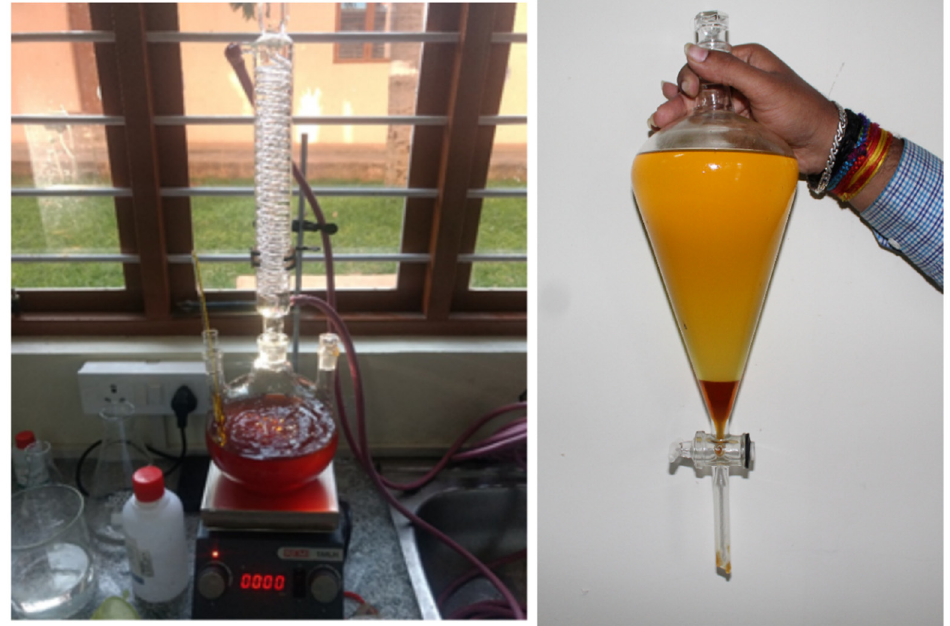
Figure 12. Experimental set up for the transesterification of discarded cooking oil and isolation of